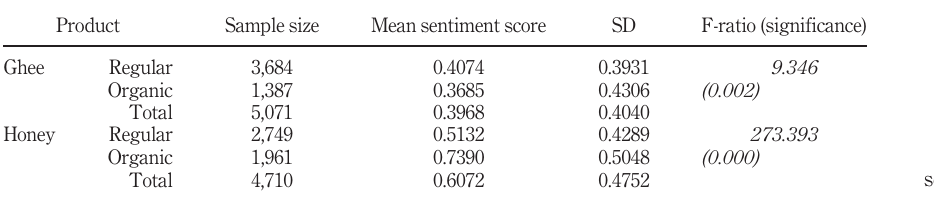
Table 5. Variations in